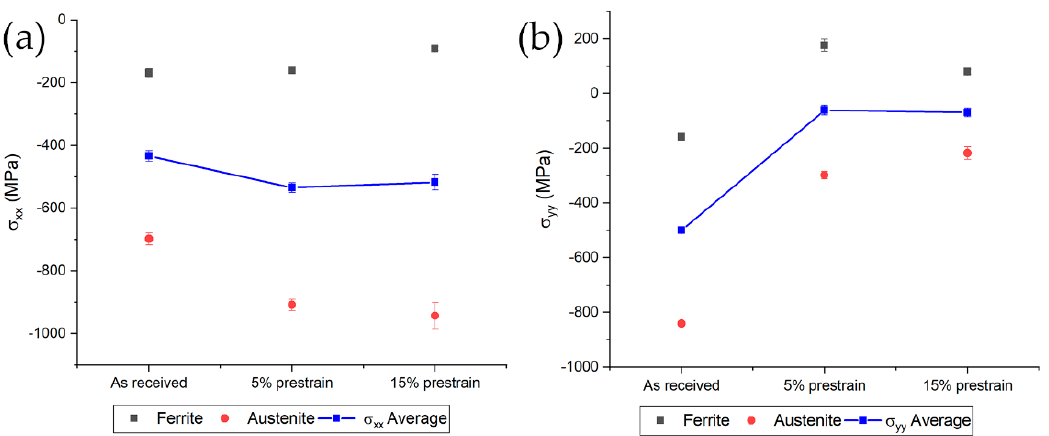
Figure 9. Residual stresses evolution on the single phases and the average along the rolling direction ( a ) and the transversal direction ( b ).